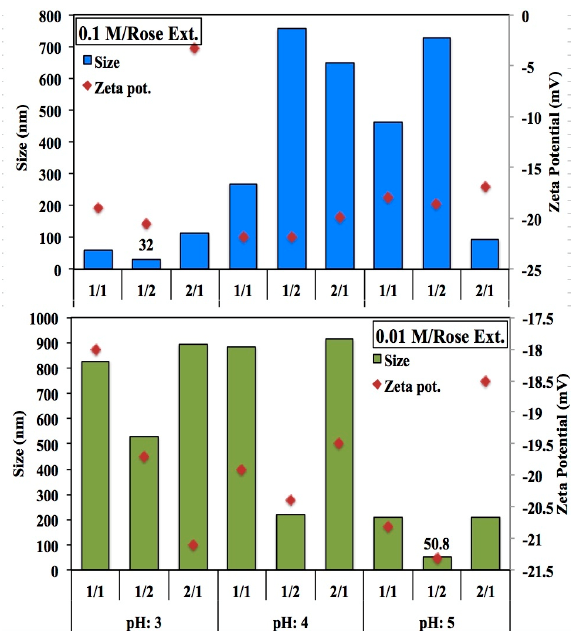
Figure 4. Comparison of the precursor/extract ratio, molarity and pH effect on the R-ZVI